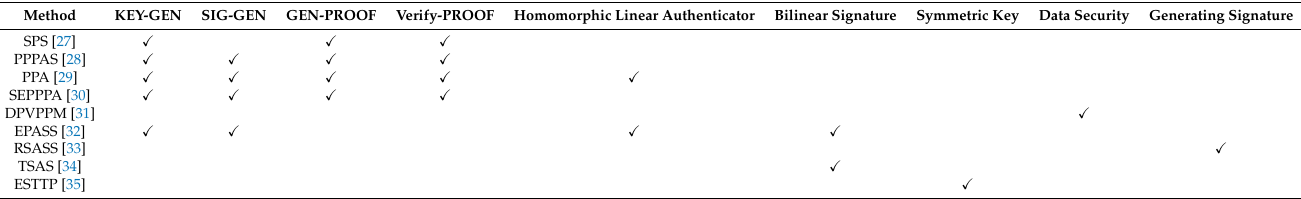
Table 2. Recapitulation based on the key schemes